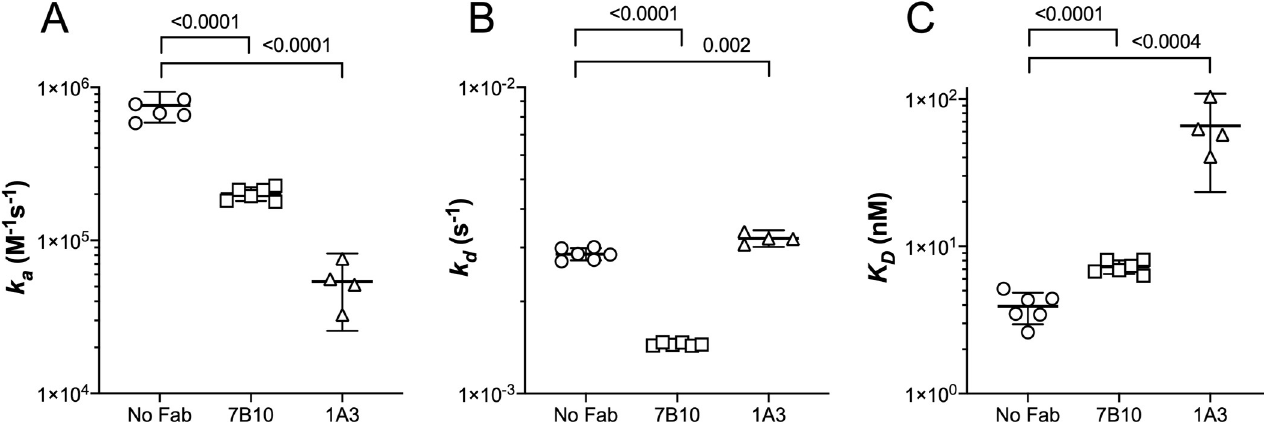
Fig 2. Kinetic parameters of Fab-mediated binding of FH to FHbp determined by surface plasmon resonance. (A) Association rate constant, k a . (B) . (C) apparent dissociation constant, K . For all three panels, the means and 2 SE of four to six replicates are shown. The p -values dissociation rate constant, k d D for two-tailed t -tests comparing the parameters of FH binding in the presence versus the absence of Fab were calculated with Prism 8.3 (GraphPad).